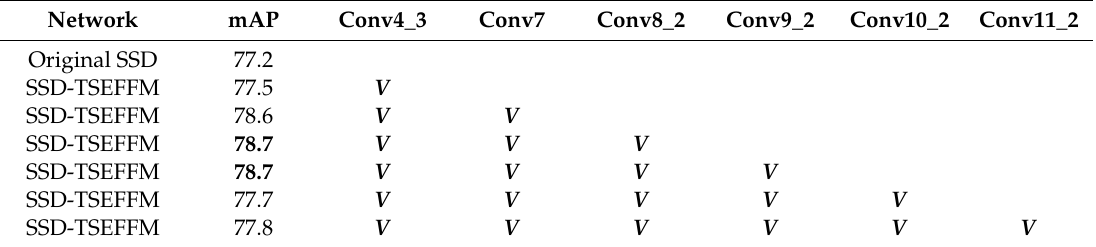
Table 3. TFM application results tested on PASCAL VOC 2007 dataset (Bold values indicate